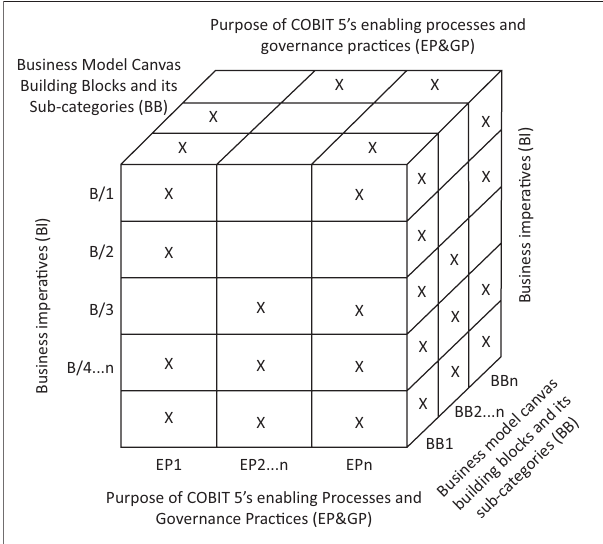
FIGURE 2: Identification of business imperatives that serve as both business (through Business Model Canvas building blocks) and IT objectives (through the COBIT enabling